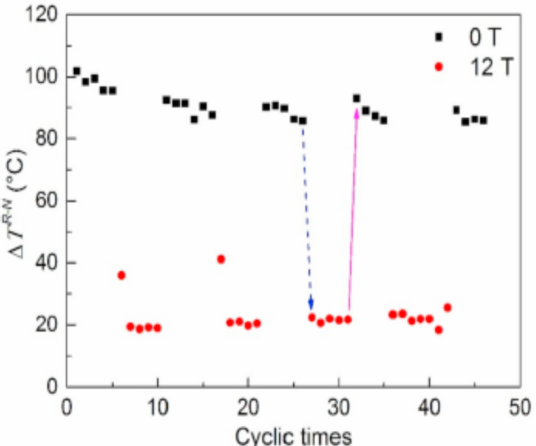
Figure 12. First peak of recalescence: Undercooling ( ∆ T) of Co at different cycling times under different magnetic fields B = 0 and B = 12 Tesla. Reprinted with permission from [81]. Copyright 2019